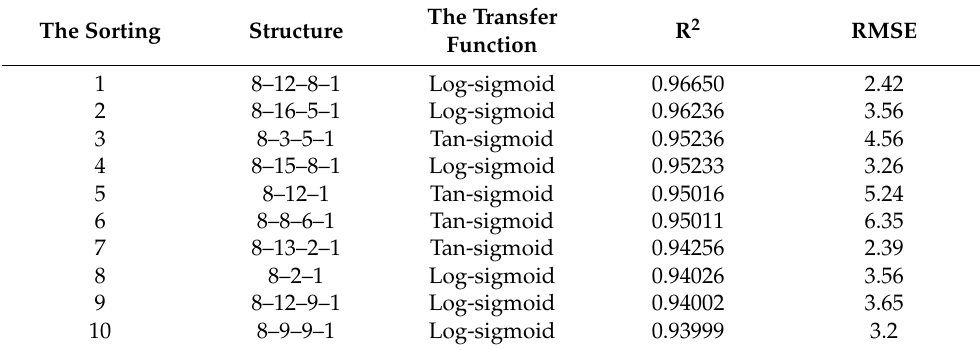
Table 8. BPNN model ranking based on correlation coefficient R 2 (TOP10).